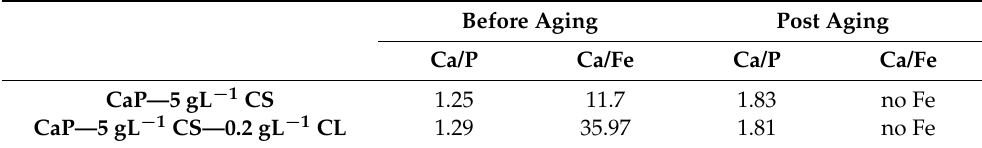
Table 1. Ca/P and Ca/Fe of the coatings before and after aging in SBF calculated from EDS results. The mean deviation is 1.3%.